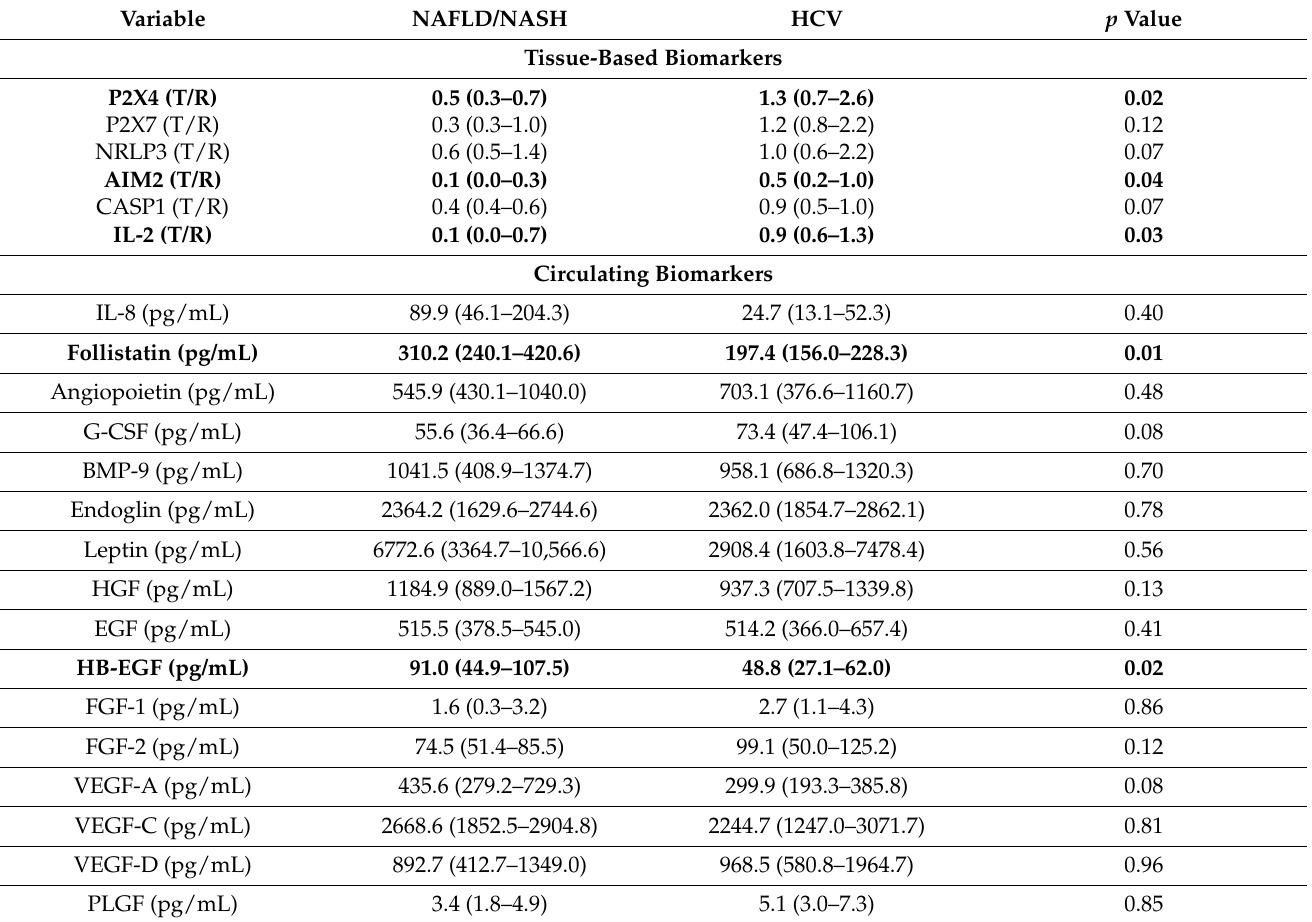
Table 3. Tissue and circulating biomarkers significantly different between HCV and NAFLD/NASH